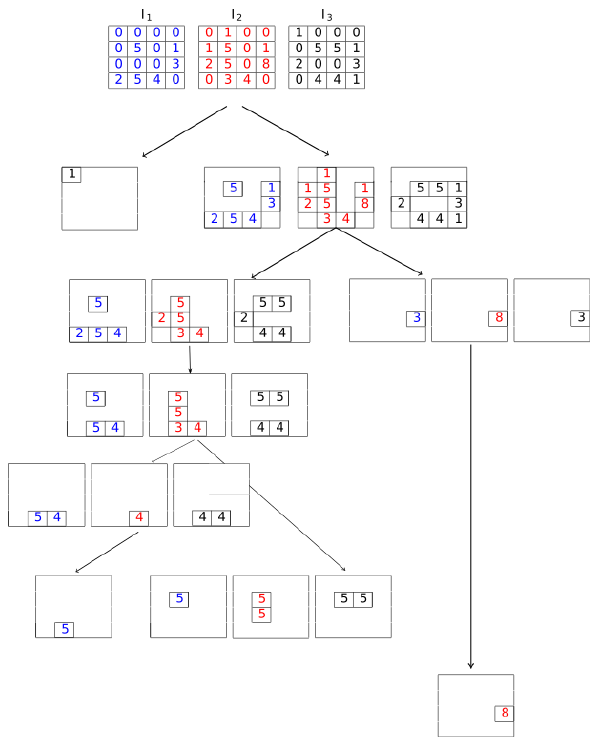
Figure 1. Space-time max-tree example (best seen in colors).